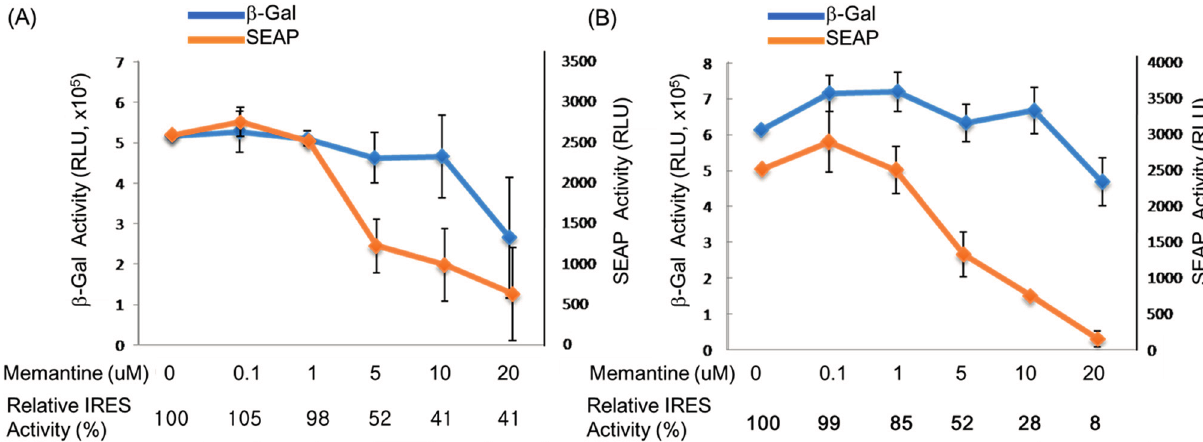
Figure 3. Effect of various concentrations of memantine on mouse N2A neuroblastoma cells. The N2A cells (~9 × 10 4 cells/well) were seeded onto a 24-well plate prior to transfection. Lipofectamine (2 μ L) was used to transfect the plasmid DNA (1 μ g) into the neuroblastoma cells. At 24 h post treatment with memantine, the culture medium from each well was harvested, the cells were lysed, and subsequent SEAP and β -galactosidase assay were done, respectively. The effect of memantine on ( A ) A β PP IRES and ( B ) tau IRES, as evaluated by beta-galactosidase (cap-dependent) and SEAP (IRES-dependent) activities in murine neuroblastoma (N2A)